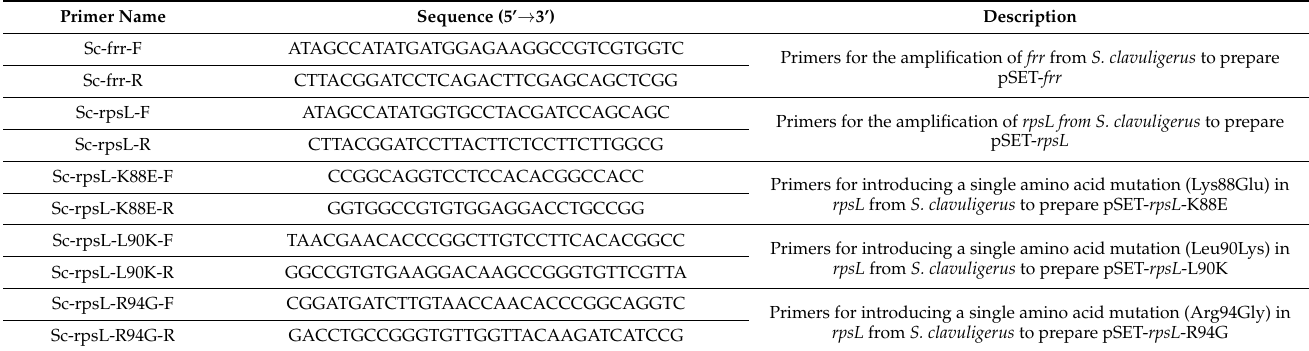
Table 3. Sequences of the oligonucleotide primers used in the current study and their